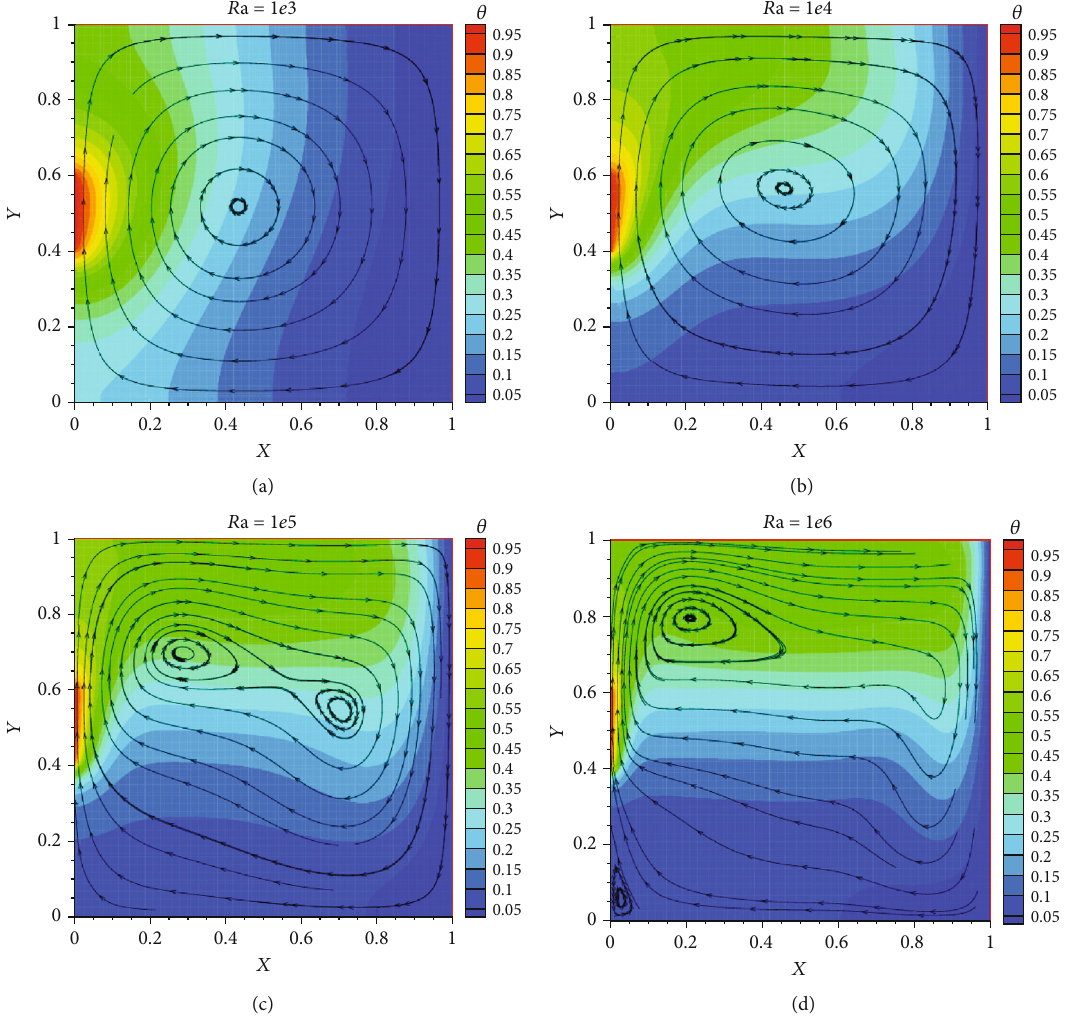
Figure 4: Streamlines overlaid on the temperature contours for (a) Ra = 10 3 , (b) Ra = 10 4 , (c) Ra = 10 5 , and (d) Ra = 10 6 , and h / H = 1/5 for hot